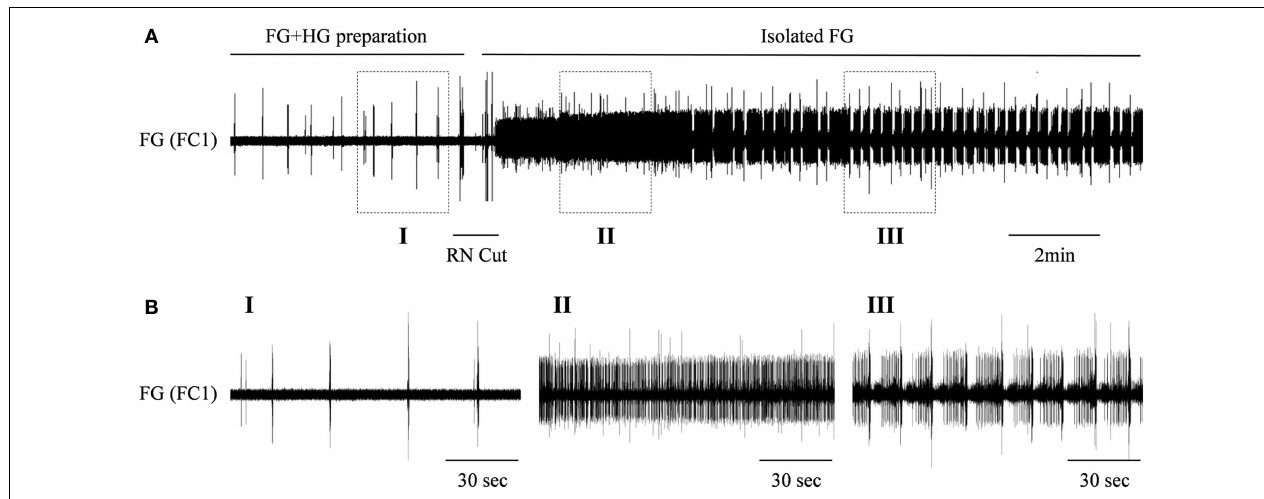
horizontal line) resulted in dense tonic firing of the FG, which later developed into high frequency of bursting activity. (B) The outlined frames marked in (A) shown on an extended time scale.